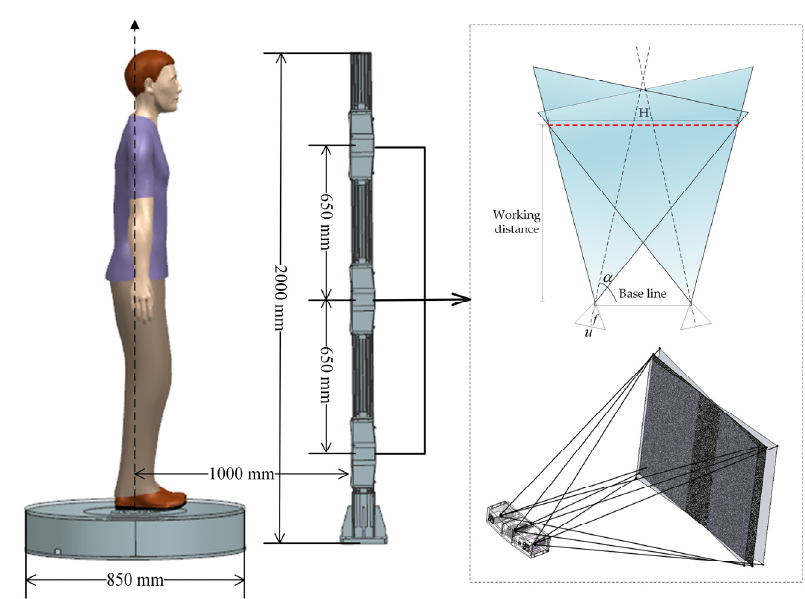
Figure 1. Scheme design for human body 3D